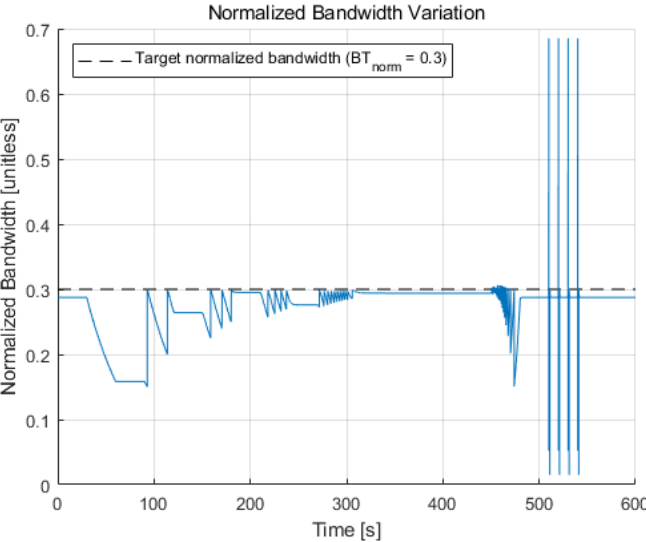
Figure 12. Normalized bandwidth variation during the simulation. The normalized bandwidth is maintained below the target normalized bandwidth value (i.e., 0.3) most of the time, except for the high dynamics region due to the unavoidable limitation of the integration time by the lower bound condition. bound